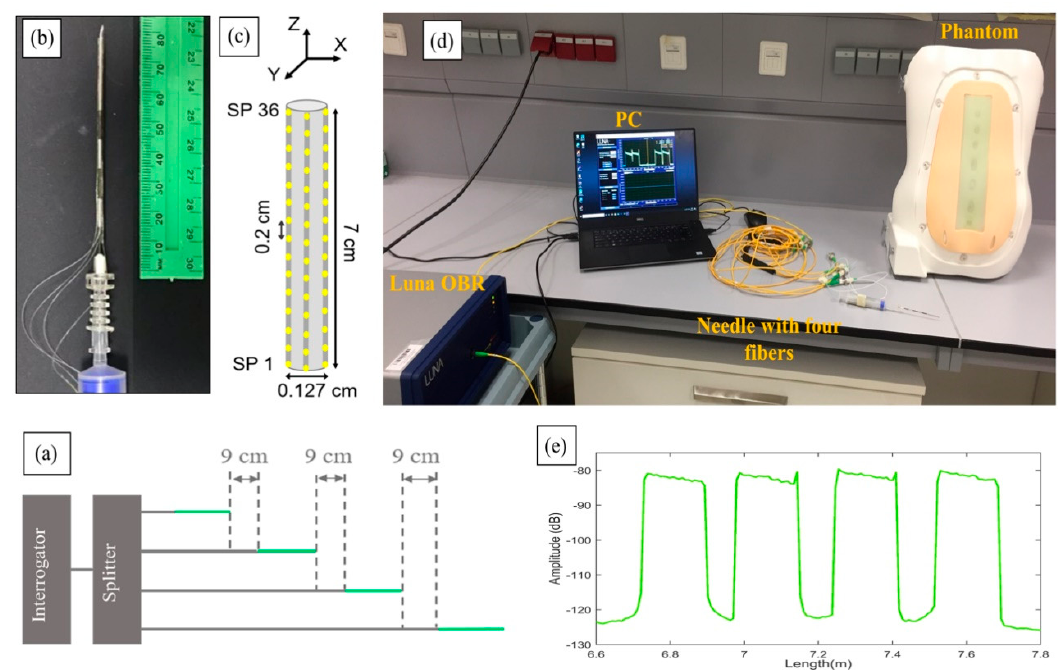
Figure 2. Experimental setup of the work. ( a ) Schematic of the multiplexing methodology of the NPDFs. ( b ) The upper view of the fiber mount on the needle. ( c ) The schematic of the fiber arrangement on the needle. ( d ) Photograph of the whole setup of the experiment. ( e ) Backscattering trace of the OBR in proximity of the 4-fiber sensing setup.